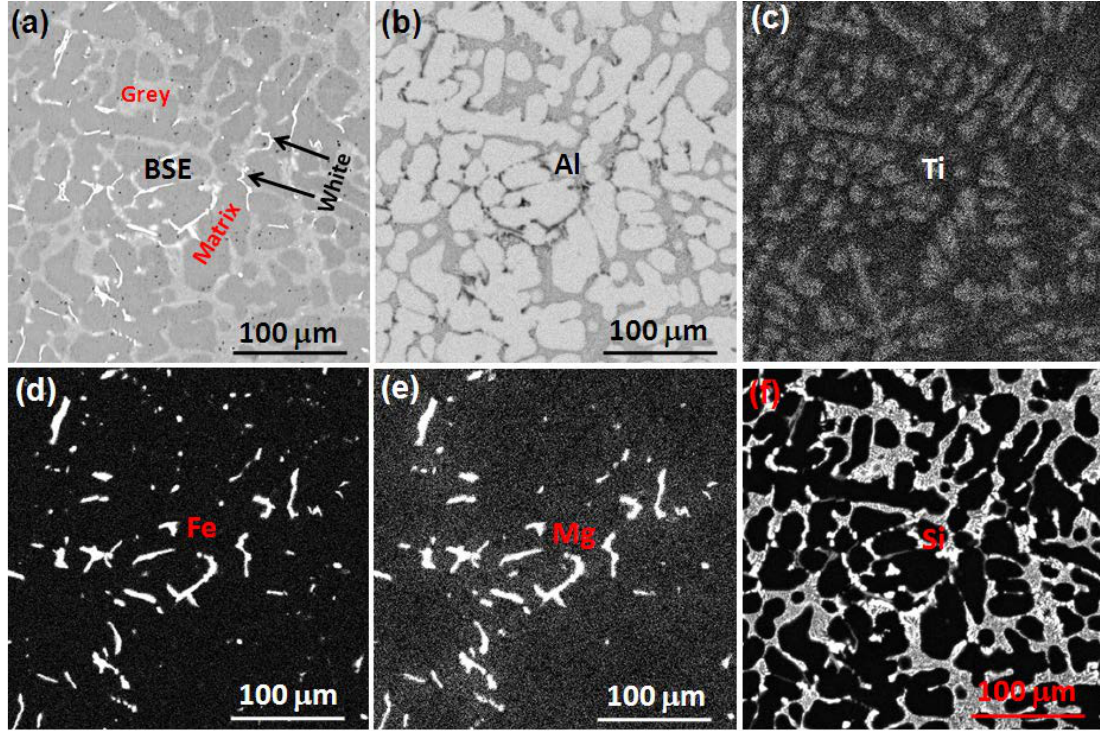
Figure 16: EPMA X-ray elemental mappings of cross section of base of the antenna: (a) BSE image (b) Al, (c) Ti, (d) Fe, (e) Mg and (f) Si distributions in corresponding BSE image.